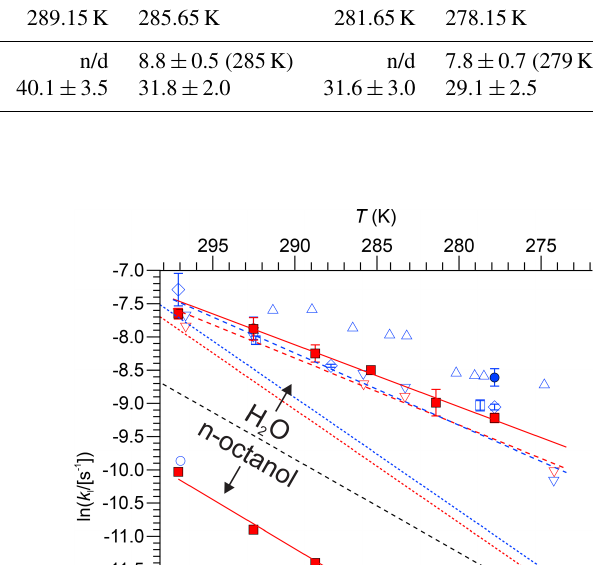
Table 3. n -Octanol–water partition coefficients of PAN and PPN calculated using Eq. (4). Compound